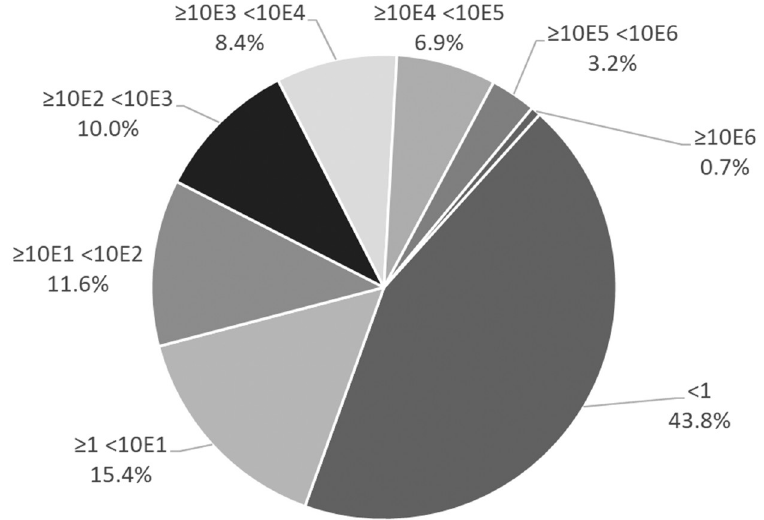
Fig 5. Pie chart reporting the percentage of each viral load category in the cohort of 6208 Covid-19 cases. Calculated viral loads are expressed as Log 10 copies/ μ L.